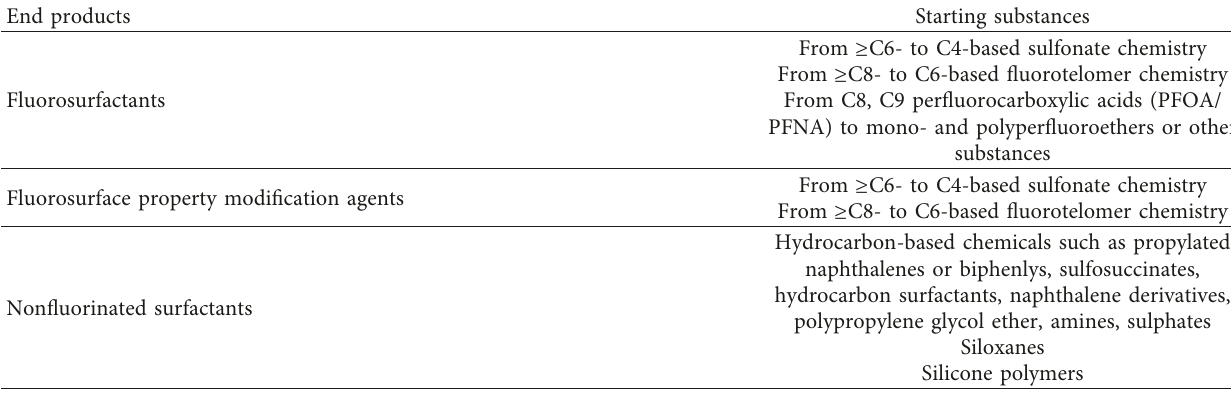
Table 3: Main transition paths in fluorochemical-based industry